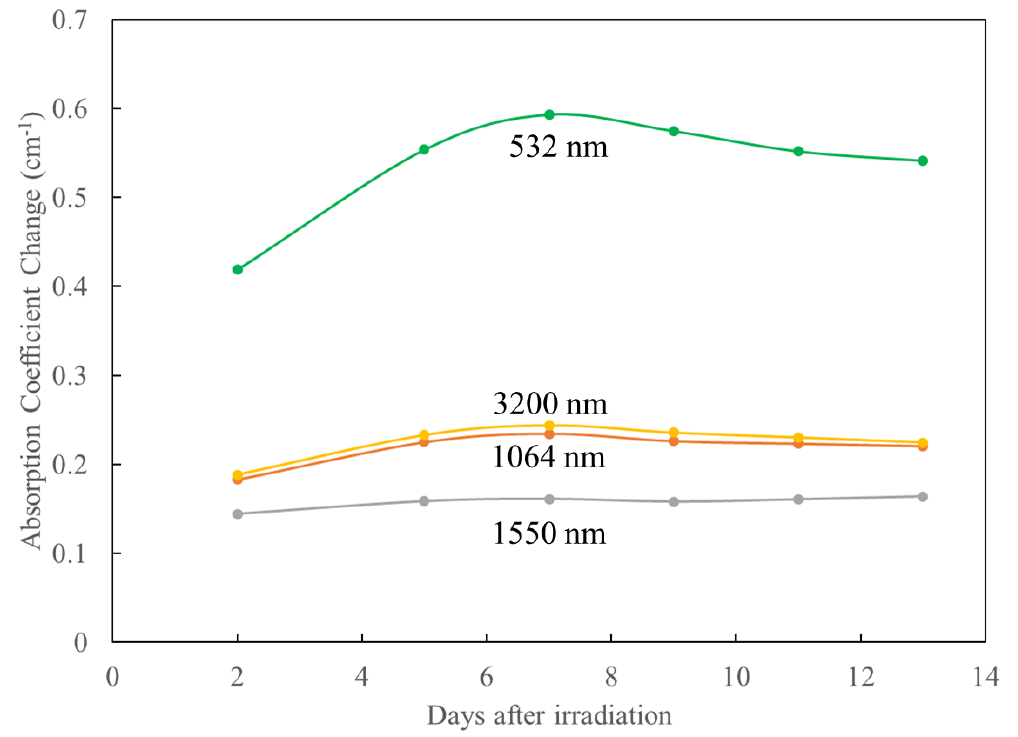
Figure 3. Dark change in absorption (for sample #3) as a function of days after neutron-gamma irradiation for four specific wavelengths. The absorption increased from day 2 to day 7 after irradiation and slightly decreased from day 7 to day 9. The change in absorption reached stationary since day 13. The dark change in absorption is not obvious for 1550 nm.